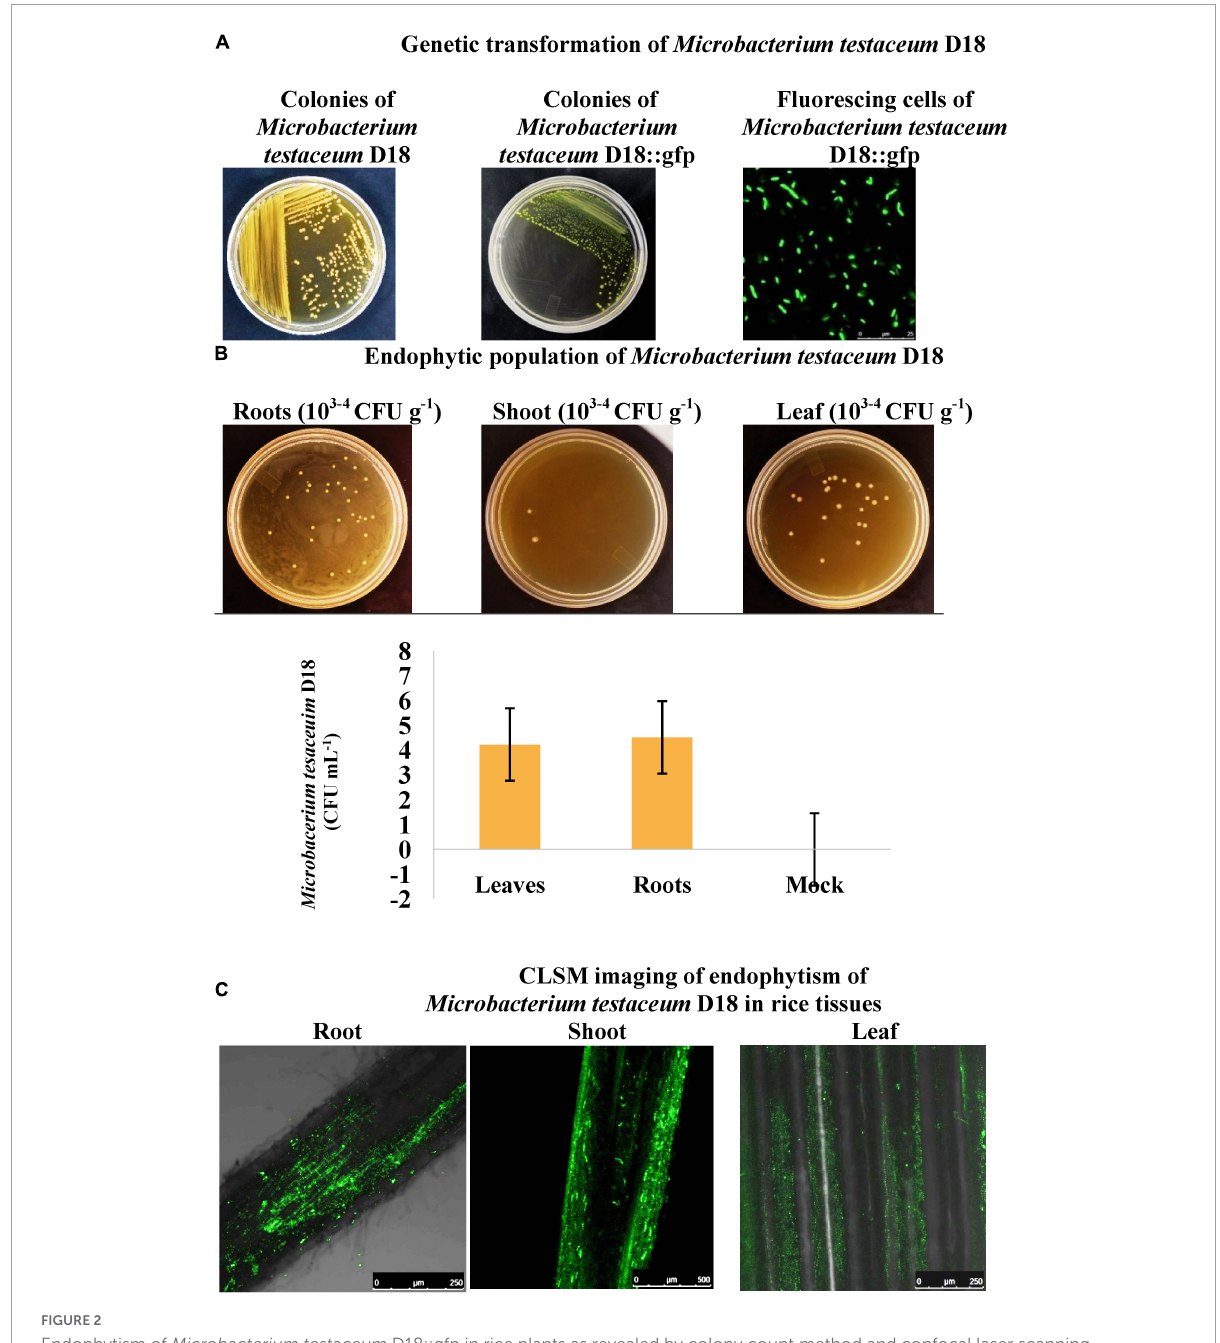
FIGURE2 Endophytism of Microbacterium testaceum D18::gfp in rice plants as revealed by colony count method and confocal laser scanning microscopy. (A) Genetic transformation of M. testaceum D18 using Tn7-based neutral integration of gfp gene. (B) Plant count method exploiting gentamycin and rifamycin resistance conferred by Tn7-based vector (pBKminiTn7gfp2Gm10). (C) CLSM imaging of endophytically colonized M. testaceum D18::gfp.